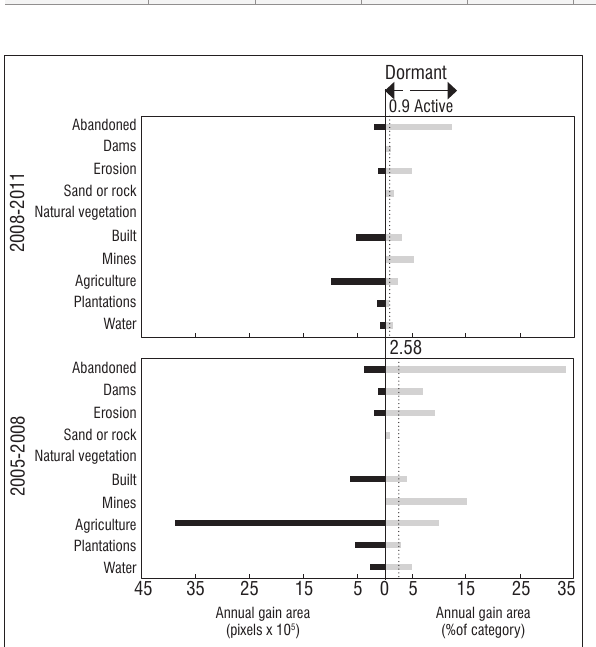
The losses per category for the 2005–2008 and 2008–2011 time intervals. The bars to the left (black) indicate the gross annual area losses per category. The bars to the right (grey) represent the intensity of the annual losses. Grey bars extending to the right or left of the vertical dashed line indicate active or dormant changes, respectively, relative to a uniform intensity across each analysis